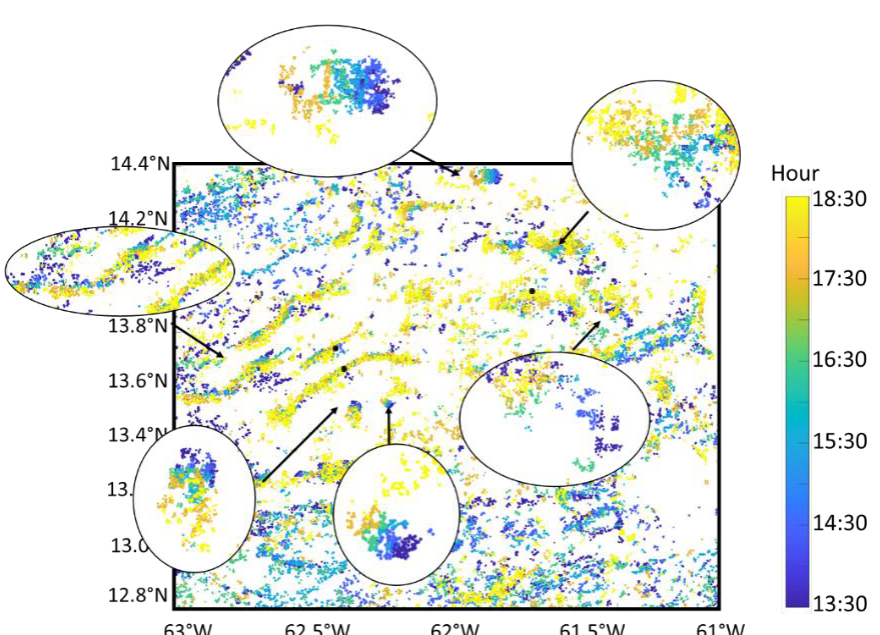
Figure 8. Superimposition of hourly GOES Sargassum identification ( δ NDVI > 0.003) over the course of 8 August 2018 to enhance the visualization of the Sargassum aggregation motion. The dot color indicates the time of observation. Some examples of Sargassum motion are enlarged.